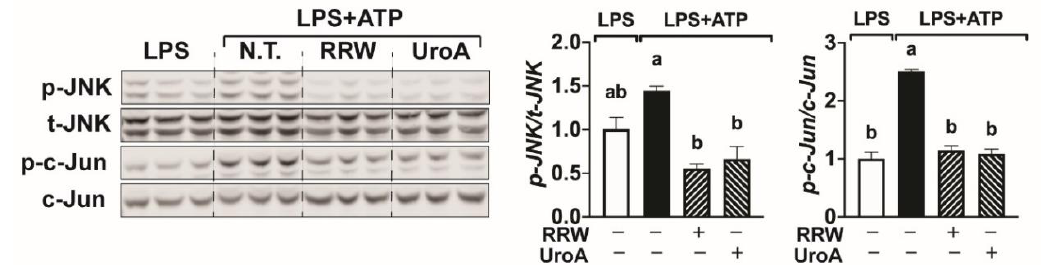
Figure 2. Both whole red raspberry polyphenols and urolithin A attenuated neuroinflammation and regulated JNK/c-Jun signaling pathways. BV-2 cells treated with LPS (500 ng/mL) for 3 h followed by ATP (2.5 mM) for 30 min with or without whole red raspberry polyphenols (10 µg/mL) or urolithin A (10 µM). Protein expression from cell lysates for p-JNK, t-JNK, p-c-Jun, and c-Jun by Western blot analysis. Relative protein intensities normalized to total-JNK or c-Jun by LICOR Image Studio Lite (right). All values are represented as the mean ± SEM. Treatments with different letters indicate significant differences by one-way ANOVA, p < 0.05. LPS = lipopolysaccharide; RRW = whole red raspberry polyphenols; UroA = urolithin A.